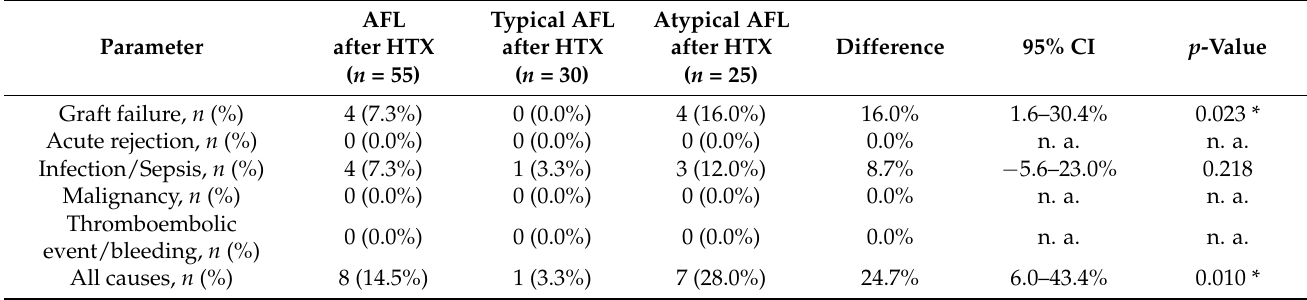
Table 8. Causes of death within one year after diagnosis of late-onset AFL after